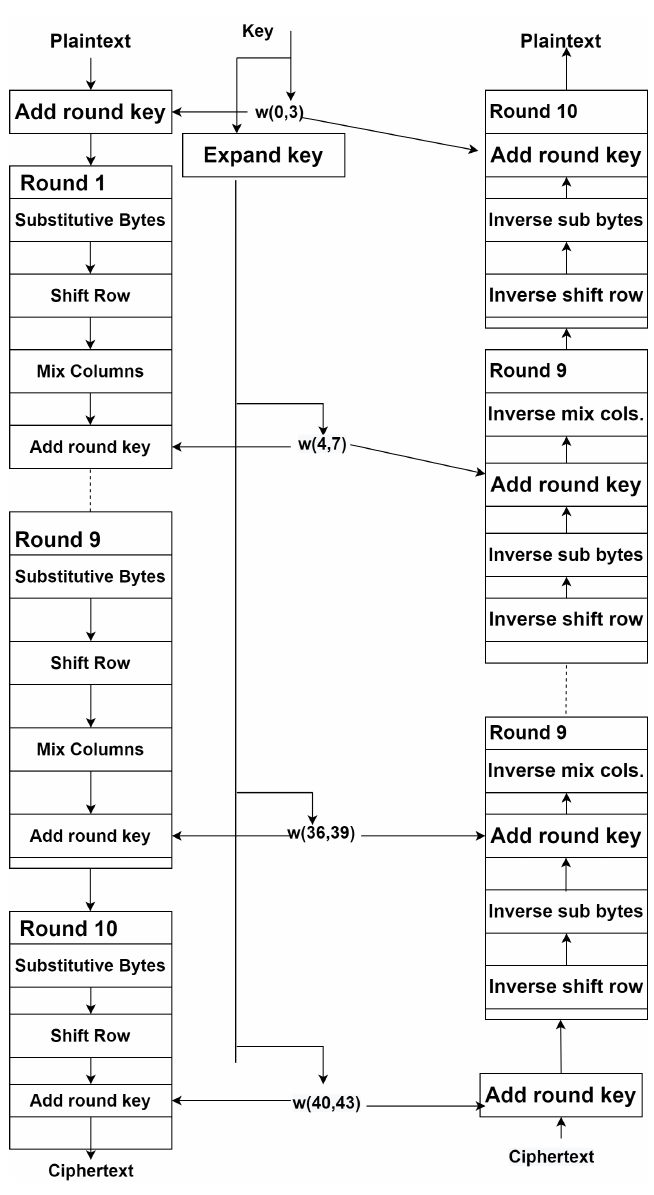
Figure 2. Working Model of Advanced Encryption Standard